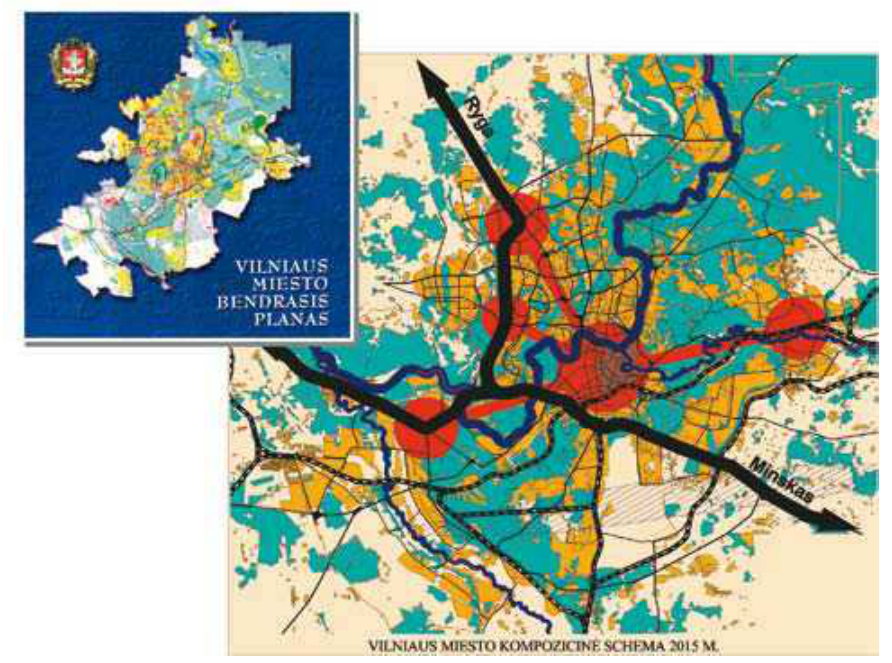
Fig. 10. The 7th Perspective Plan of Vilnius City development (Official Plan